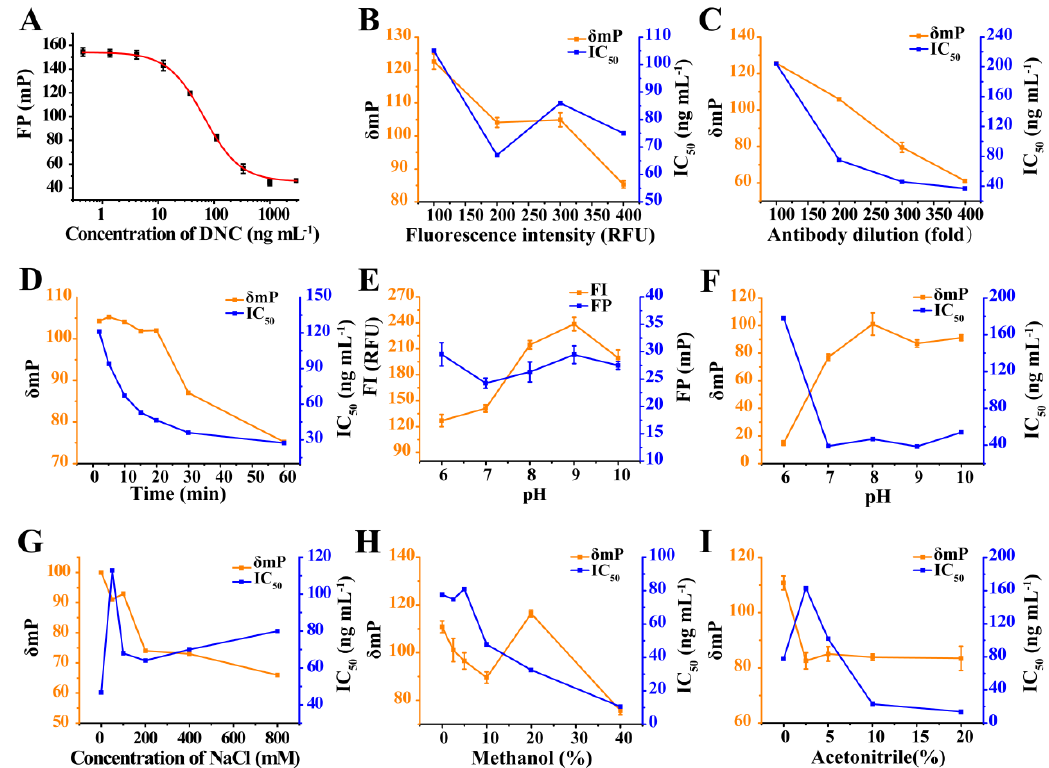
Figure 4. ( A ) Standard curves for DNC using DNC-4-BDF and mAb 3B4 combination. ( B ) Optimization of fluorescence intensity. ( C ) Optimization of antibody dilution. ( D ) Optimization of incubation time. ( E ) The effects of pH on FI and FP values. ( F ) Optimization of pH. ( G ) Optimization of NaCl concentration. ( H ) Effects of methanol concentration on assay performance. ( I ) Effects of acetonitrile concentration on assay performance.